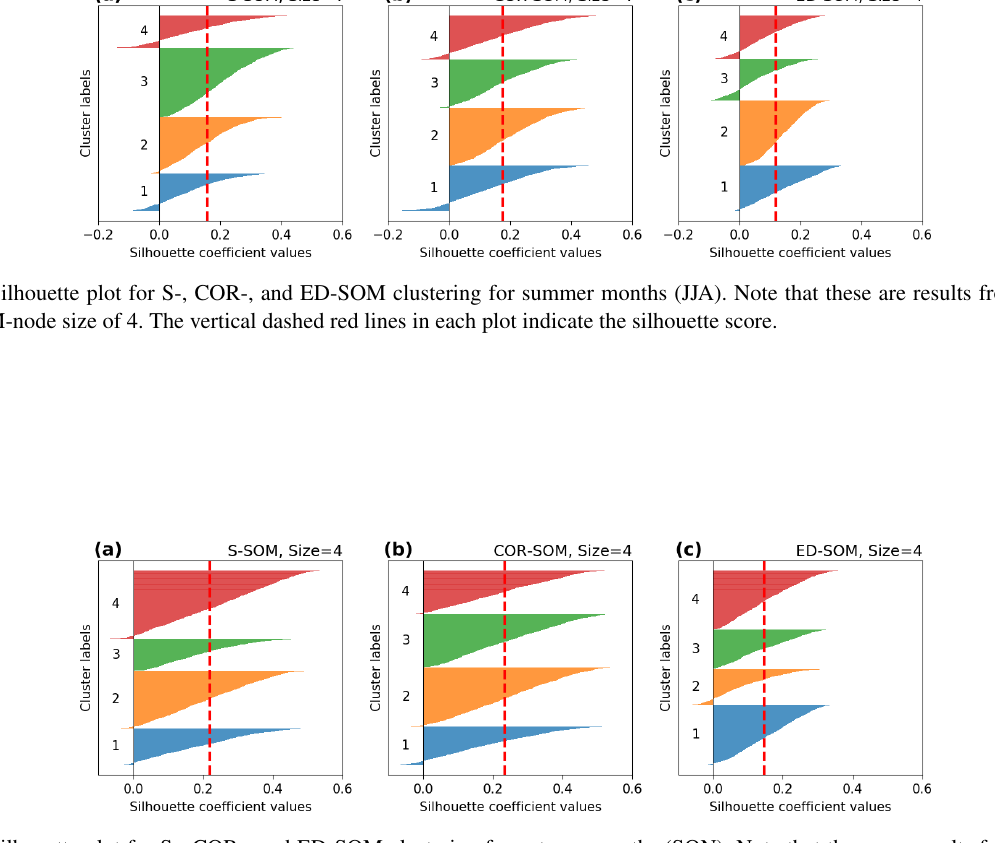
Figure A7. Silhouette plot for S-, COR-, and ED-SOM clustering for autumn months (SON). Note that these are results from simulations with the SOM-node size of 4. The vertical dashed red lines in each plot indicate the silhouette